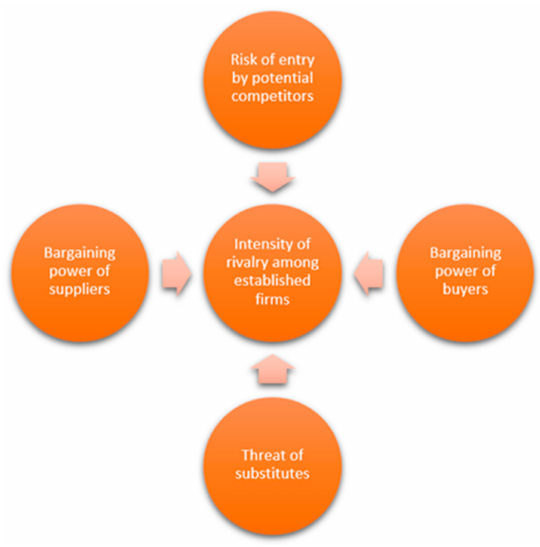
Figure 1. Porter’s Five Forces model. Source: adapted from [53] (p.